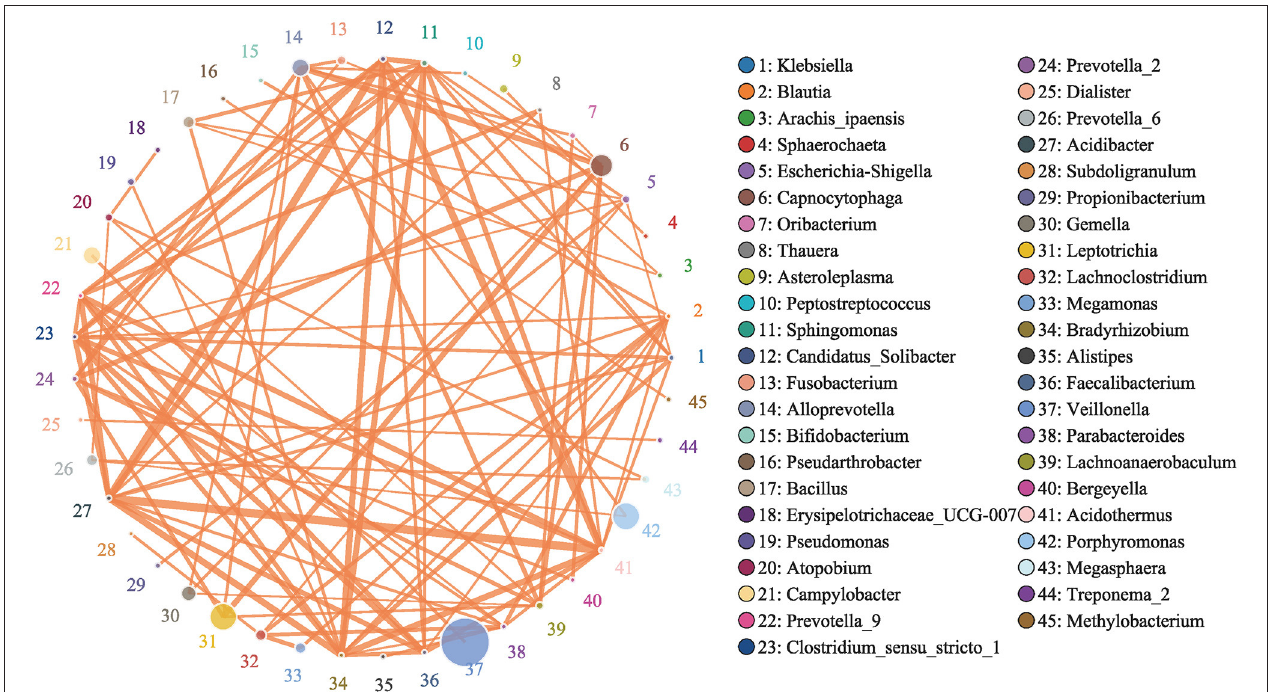
FIGURE 13 | Network of Bacteria. Analyzed by Spearman rank correlation analysis. The size of the circle represents the average abundance of the species; the line represents the correlation between the two species; the thickness of the line represents the strength of the correlation; and regarding the color of the line, orange represents a positive